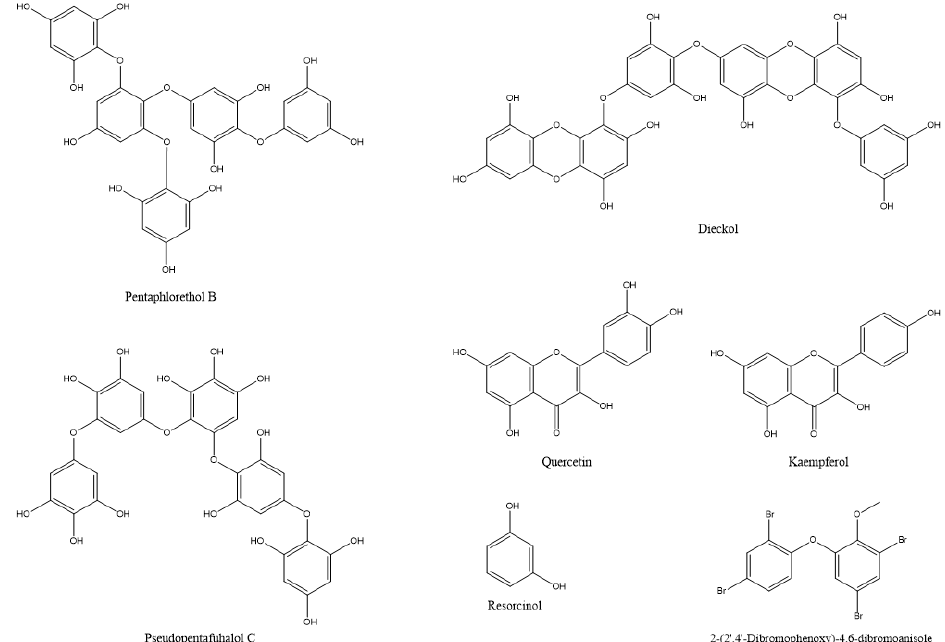
Figure 2. The chemical structures of active compounds that were isolated from Cladaphora fascicularis and Arthrospira platensis and other microalgae.